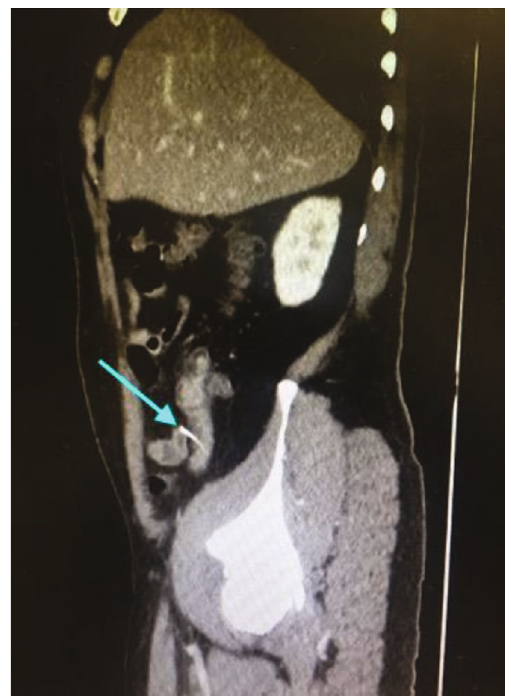
Figure 4: CT scan of case number 3 showing foreign body (arrow).